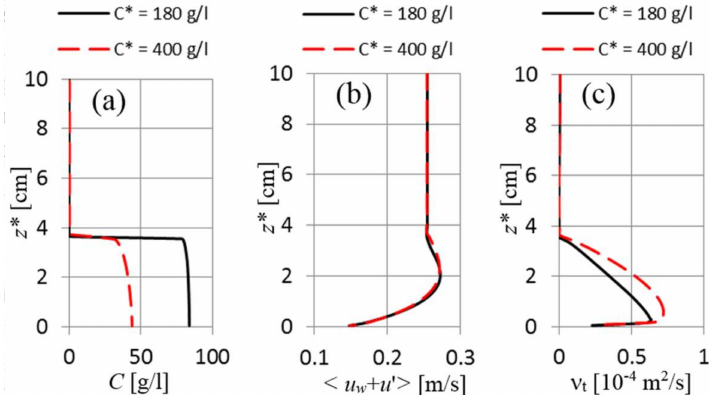
Figure 9. Main configuration with u a = 40 cm/s and C * = 180 g/L (dashed lines) or C * = 400 g/L (solid lines). Equilibrium vertical profiles of ( a ) suspended sediment concentration, C ; ( b ) horizontal velocity, u w + u ’, averaged over a wave period, and ( c ) vertical eddy viscosity, ν t , noting that effective sediment viscosity remains insignificantly small, ν e < 0.1 × 10 − 4 m 2 /s throughout the fluid mud layer. z * is distance from the seabed. This figure shows the dynamical properties of the lutocline layer. Here, a wave forcing of u a = 40 cm/s creates a lutocline at ~3.5 cm above the bed (Figure 9a).